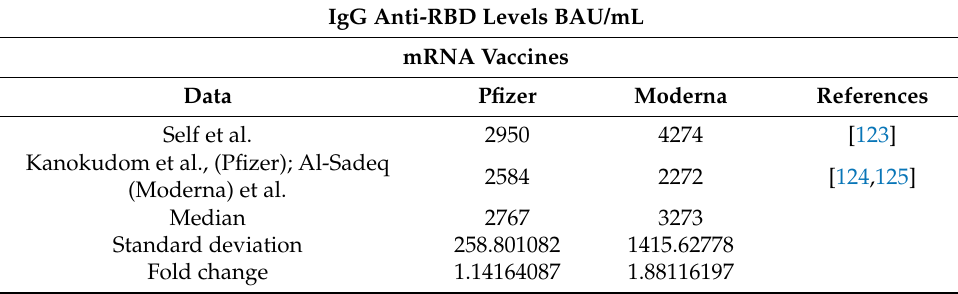
Table 3. Beneficial immune responses in mRNA COVID-19